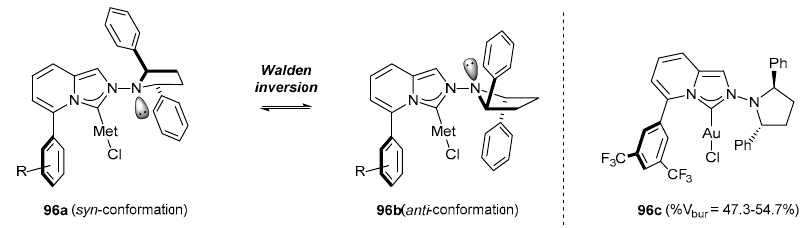
Figure 2. Walden inversion of metal complexes bearing chiral 2,5-diphenylpyrrolidin-1-yl subunit.